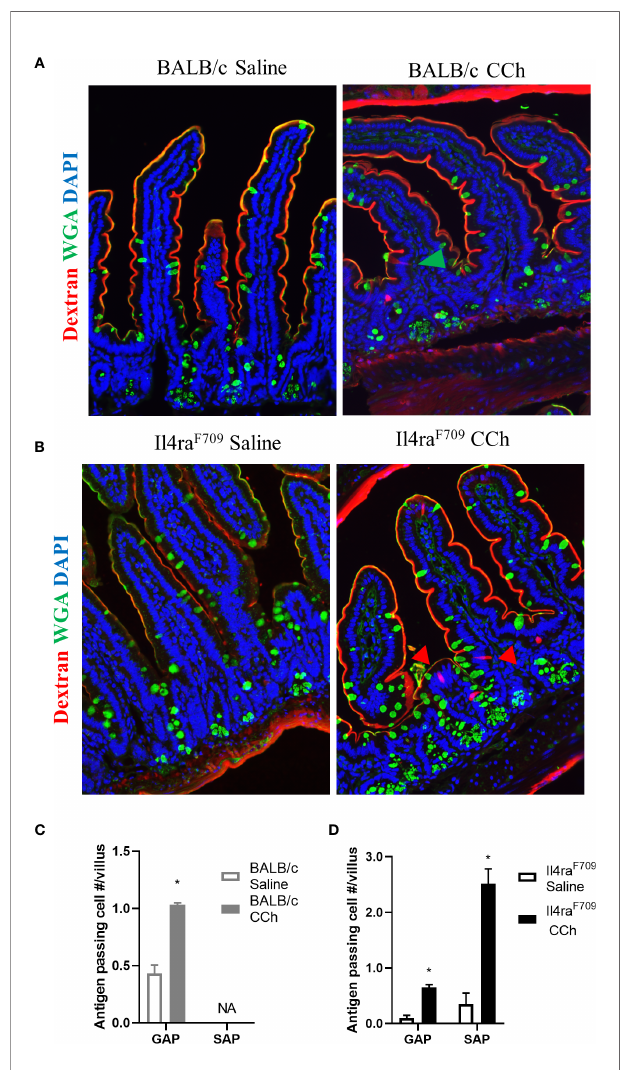
FIGURE 1 | Antigen passage formation is altered in Il4ra F709 . Immuno fl uorescence analysis for WGA (green) to identify goblet cells and dextran (red) with the small intestine of (A) wild type BALB/c mice and (B) Il4ra F709 mice treated with saline or CCh. The nucleus is visualized with DAPI (blue). The green arrow points to GAP, and the red arrows point to non- GAPs. Quanti fi cation of antigen passage formation in (C) wild type BALB/c and (D) Il4ra F709 mice treated with saline or CCh. n=3 per group. *denotes statistical signi fi cance, p<0.05. NA indicates 0 value. SAP includes antigen passages across goblet and non-goblet